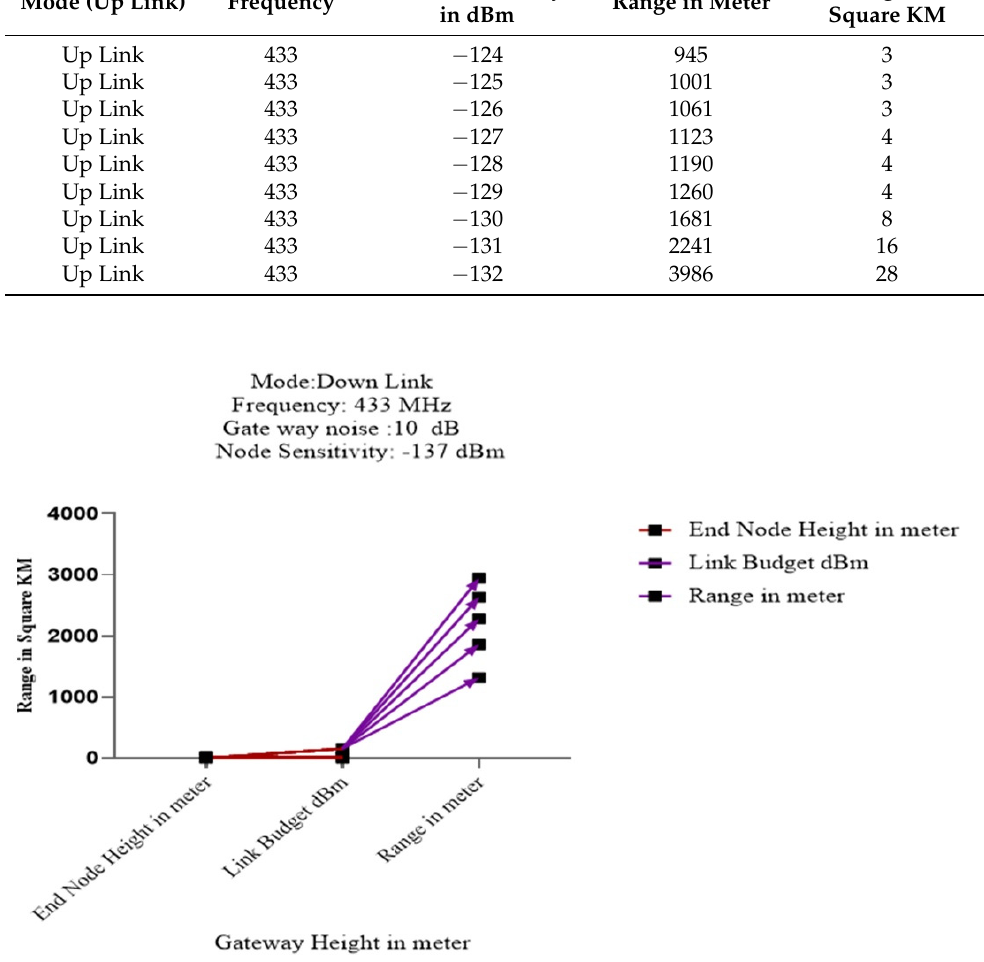
Figure 13. Link budget variation with range.